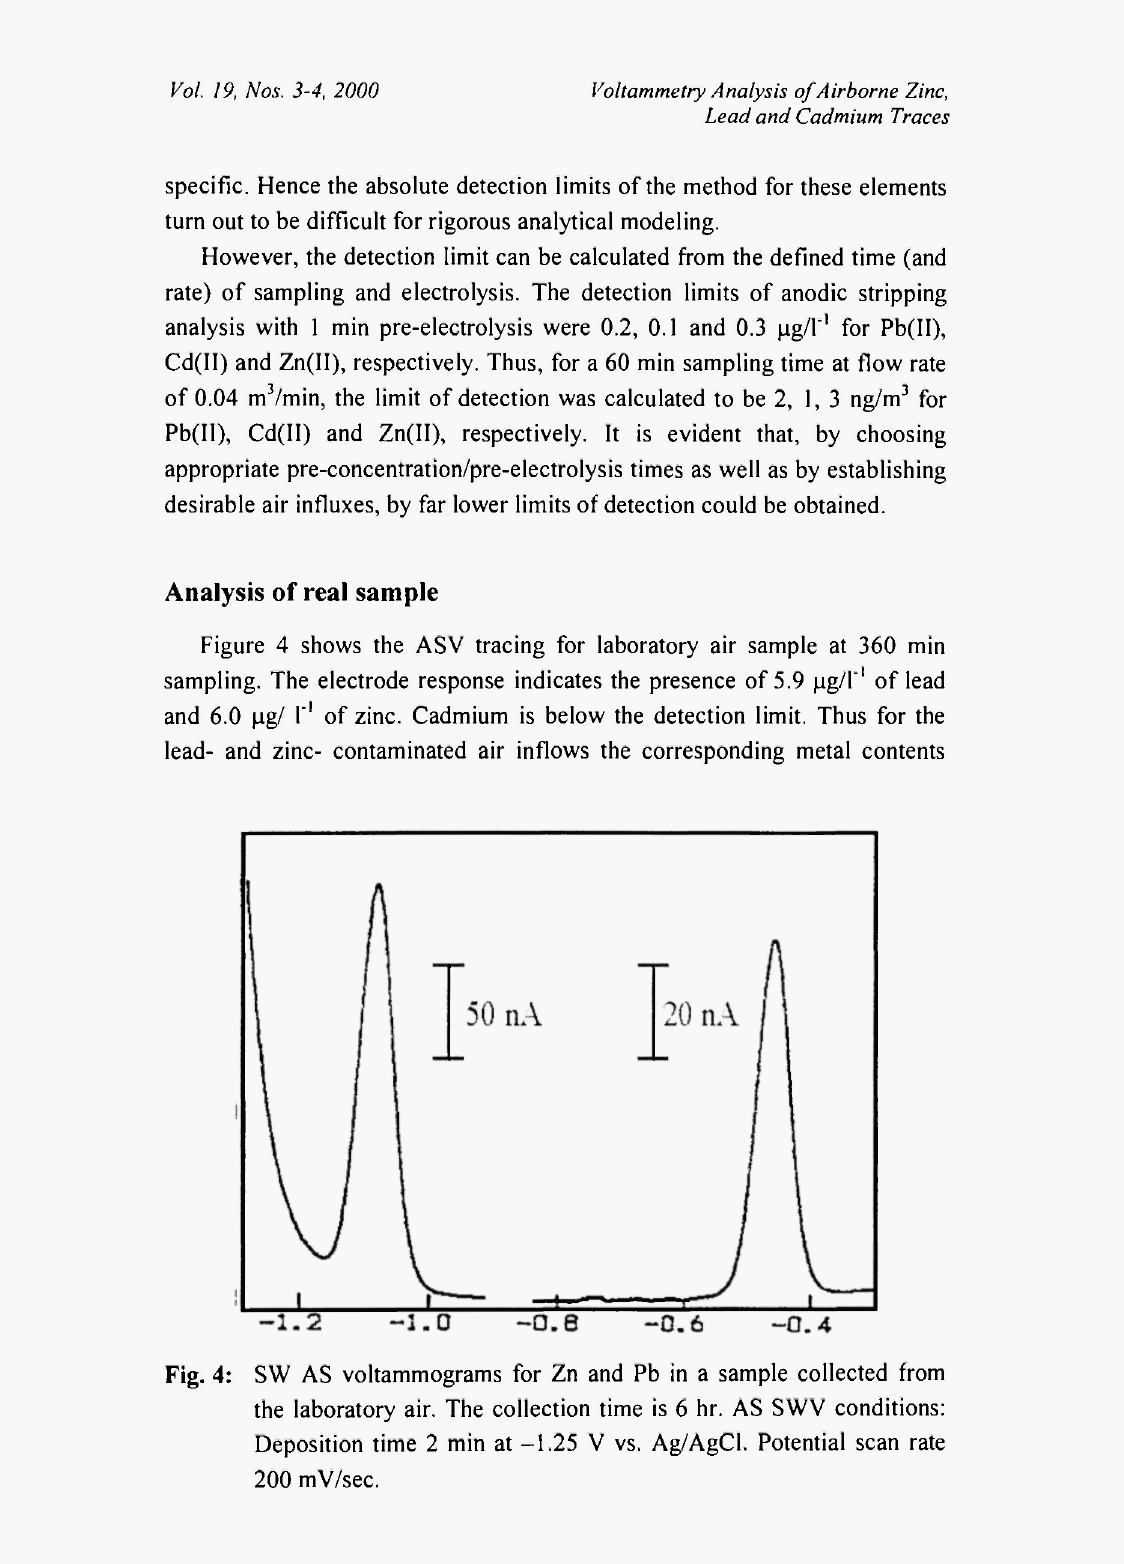
Fig. 4: SW AS voltammograms for Zn and Pb in a sample collected from the laboratory air. The collection time is 6 hr. AS SWV conditions: 200